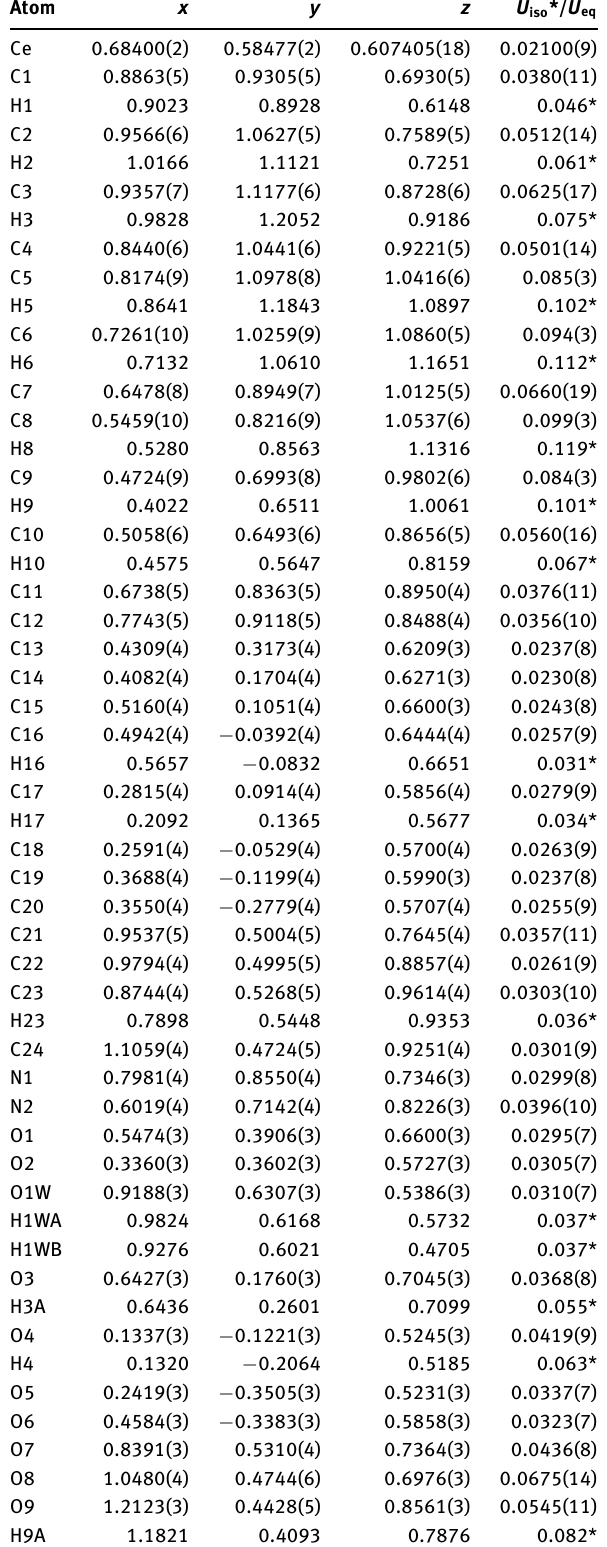
Table 2: Fractional atomic coordinates and isotropic or equivalent isotropic displacement parameters (Å 2